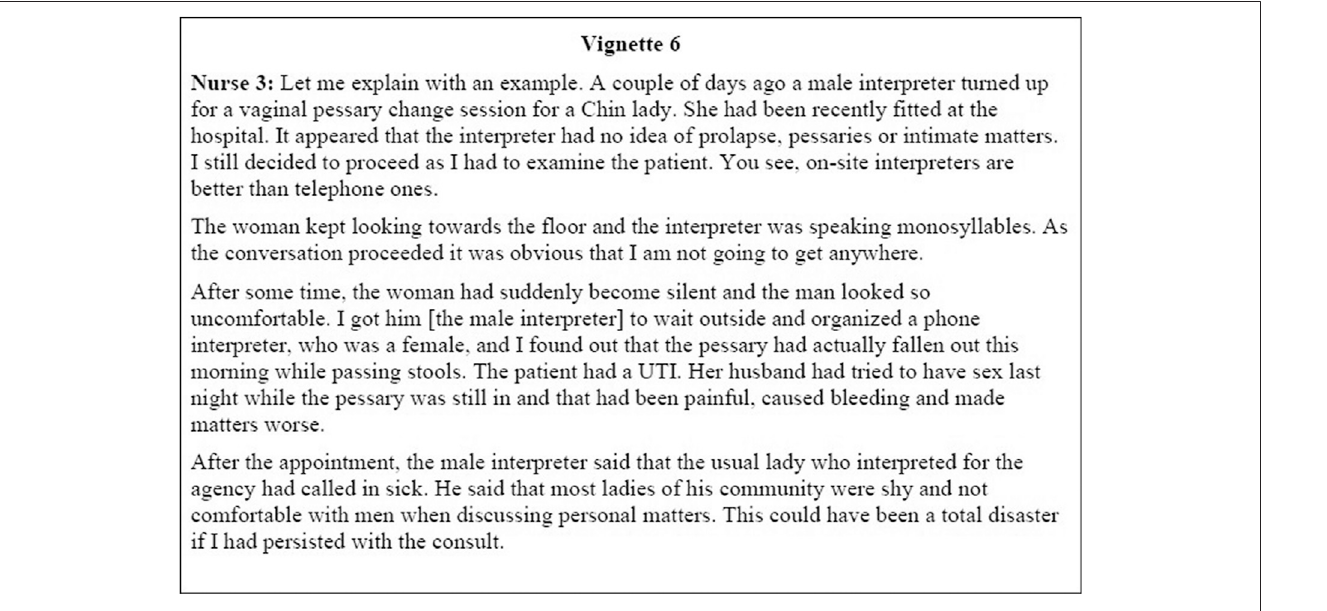
FIGURE 6 | Gender matching of interpreters with